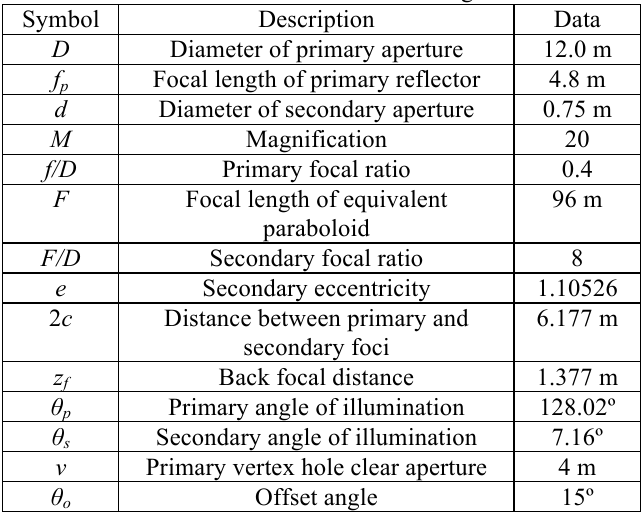
Table 3: Parameters for the off-axis Cassegrain antenna.